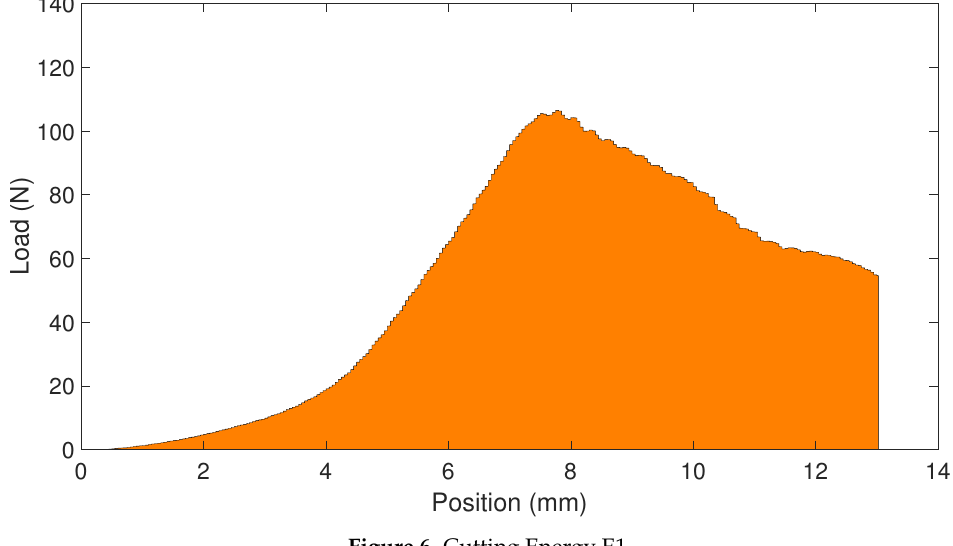
Figure 6. Cutting Energy